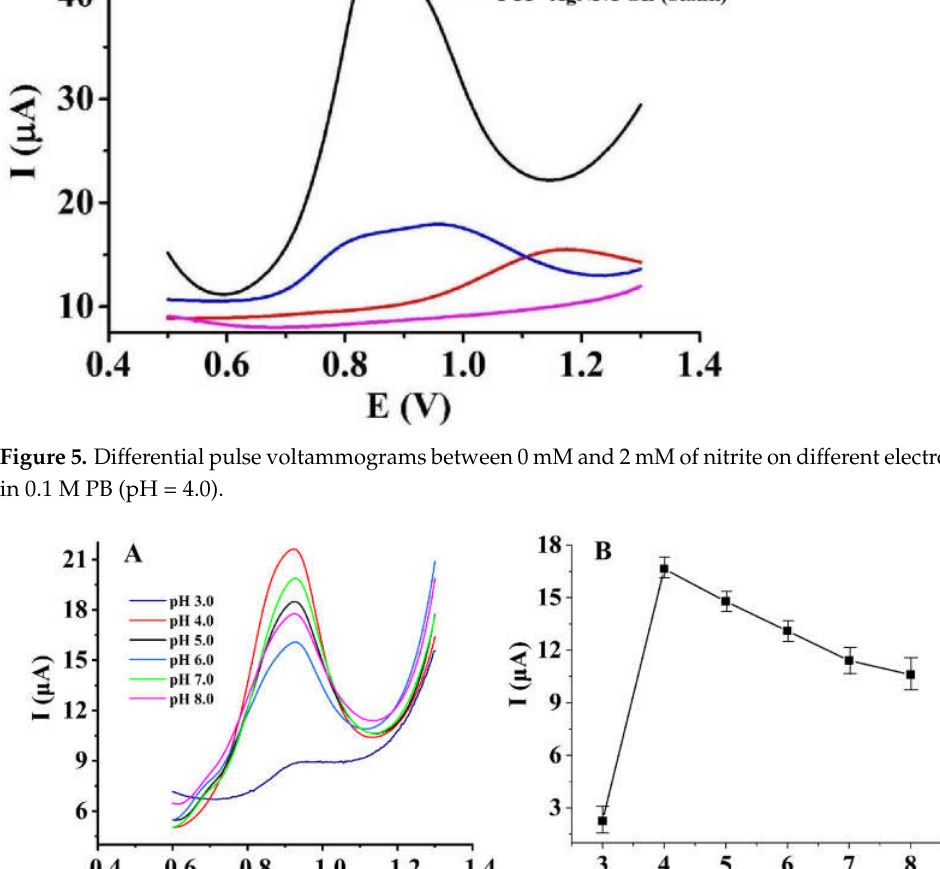
Figure 7. The relationship between Q and t for bare PGE and PTP−AgNP/PGE ( A ) and the linear relationship between Q and t 1/2 for bare PGE and PTP−AgNP/PGE ( B ). Q = 2ncFAD 01/2 t 1/2 π  1/2 + Q dl + nFAΓ 0